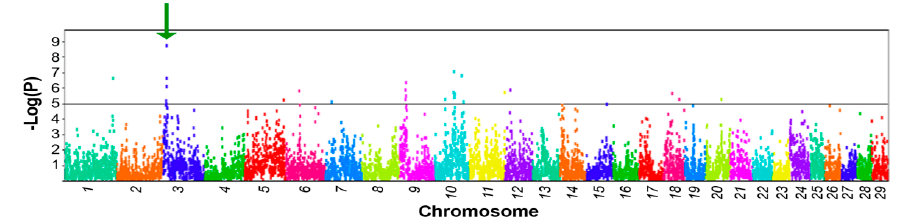
Figure 1. Genome-wide association analysis of basal CD18 leukocyte counts. Omnibus p -values for 15-SNP haplotype association were determined using PLINK. Green arrow points to the most probable association. Black horizontal line denotes the threshold value of significance considering Bonferroni correction for multiple comparisons. Table 1. Association of BTA3 haplotype alleles with CD18 leukocyte counts 1 .